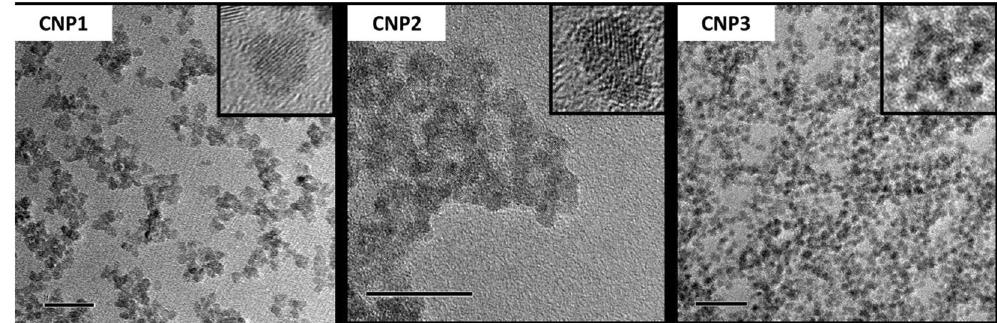
Figure 1. CNP (Left to Right, CNP1,2,3) size characterization (TEM images) with insets illustrating crystallinity (all scale bars are 20 nm). All formulations show aggregation due to the high reactivity of NP surfaces. Images show well-formed, individual crystallites. Further, these images highlight the crystallinity of these particles through the clear presence of lattice fringes.